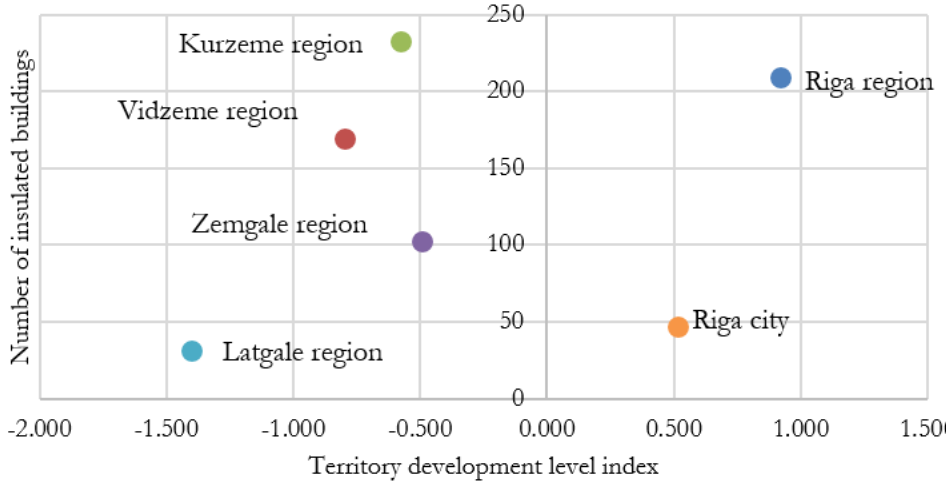
Figure 3. The territory development level index of regions/cities and number of renovated projects in different regions from 2008 to 2013.